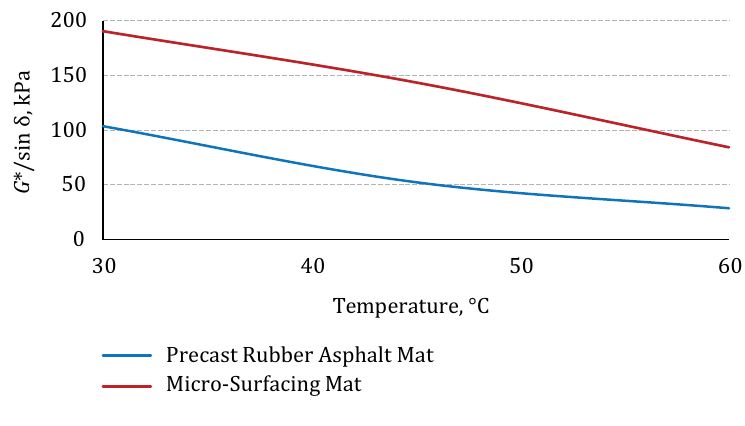
Figure 12. G of Micro-Surfacing Mat and Precast Rubber Asphalt * /sin δ